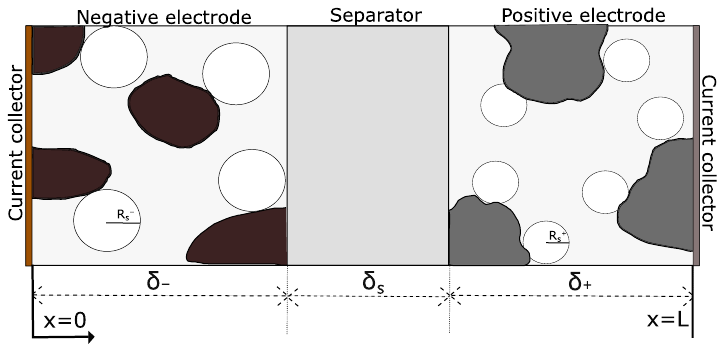
Figure 1. DUAL cell sandwich battery, cross-sectional view. The current collectors are located at the extremes of the cell, inspired by